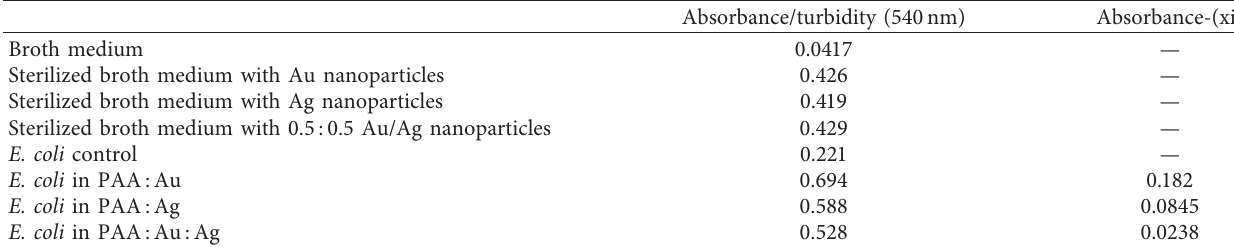
Figure 9: Investigation of the antimicrobial activity of different PAA solutions against S. aureus . (a) Control plate with Muller Hinton agar and inoculated S. aureus bacteria. (b) Plate treated with AuNPs-PAA (c) Plate treated with AgNPs-PAA (d) Plate treated with Au/AgNPs- PAA demonstrating a larger zone of inhibition than the plate treated with AgNPs-PAA. Table 1: UV-visible absorbance for broths treated with E. coli .